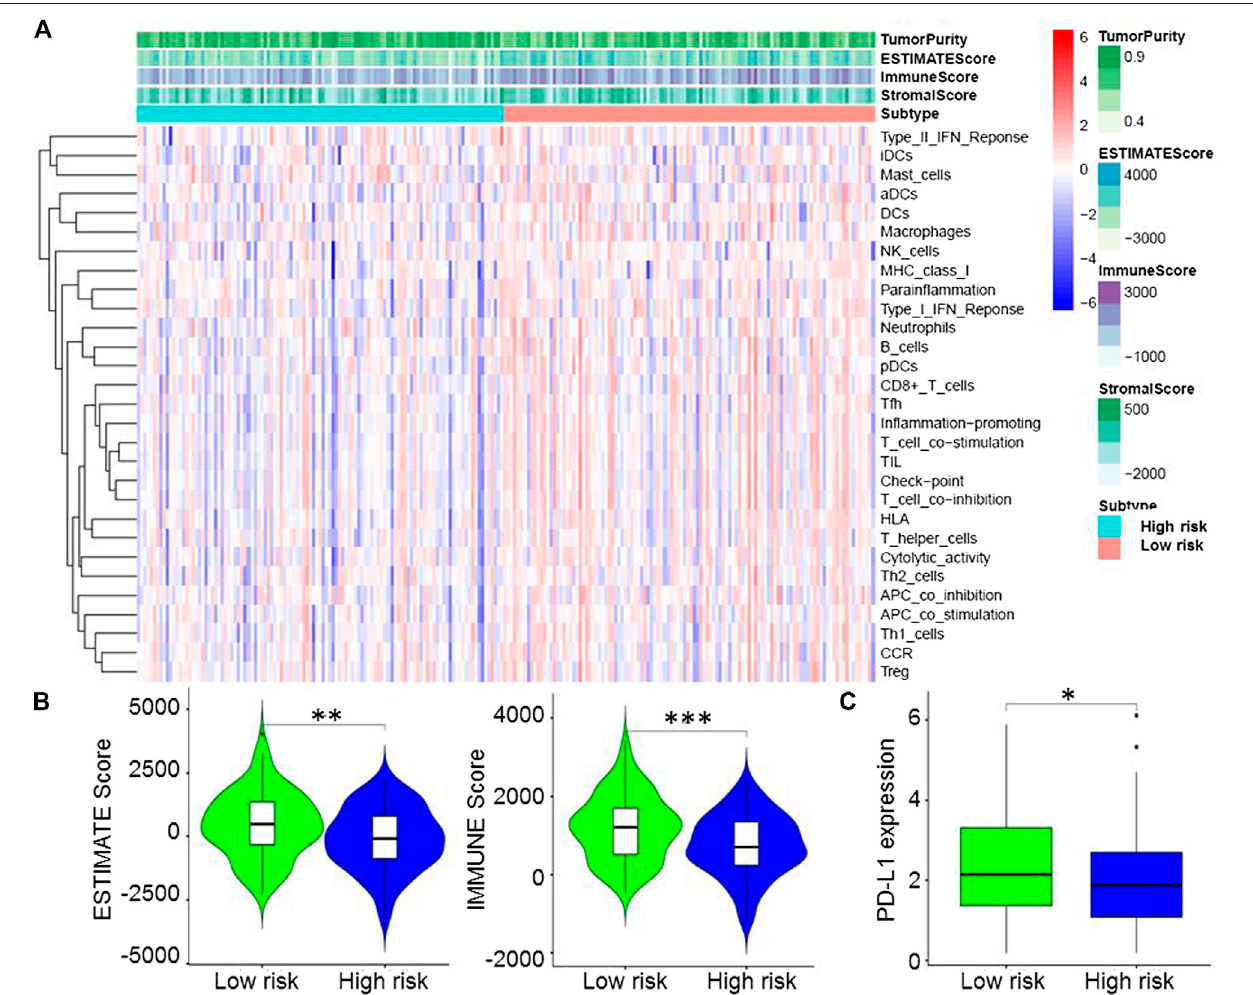
FIGURE 5 | Immune microenvironment of the high- and low-risk groups. (A) , Estimation of STromal and Immune cells in MAlignant Tumors using Expression data (ESTIMATE) analysisshowed thattheimmunescoreofthe low-risk groupwashigher than thatofthe high-riskgroup. (B) , ESTIMATE analysis indicated thatthelow-risk group had more immune and stromal cells but lower tumor purity. (C) , Programmed death-ligand 1 expression of the low-risk group was higher than that of the high- risk group.